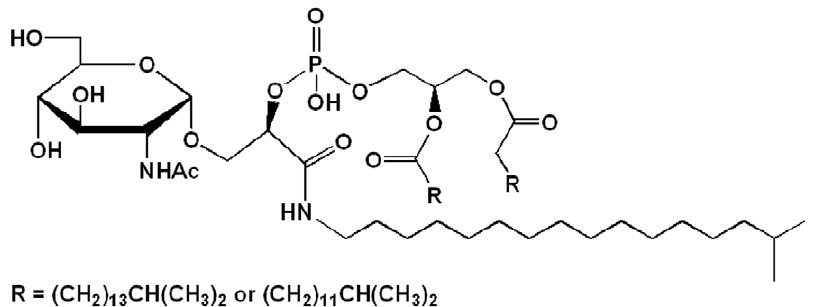
Figure 2. Proposed structure of the acidic glycolipid (AGL-B) from T.thermophilus HB8.